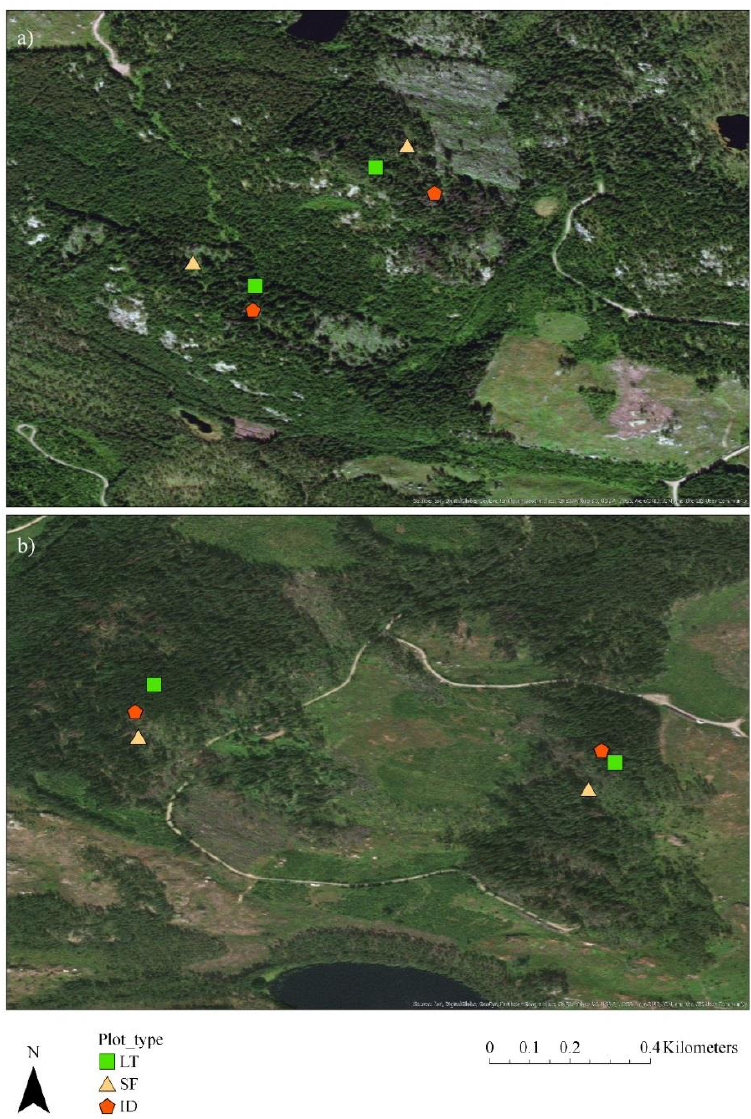
Figure 1. Locations of study plots in Paajasensalo ( a ) where plots established in 2015 are on the left and plots established in 2016 are on the right, and Viitalampi ( b ) where plots established in 2015 are on the right and plots established in 2016 are on the left. LT = living tree plot (green squares), SF = storm-felled tree plot (light brown triangles), and ID = tree killed by I. typographus plot (red pentagons). Created using ArcGIS (ESRI, Redlands, CA, USA).